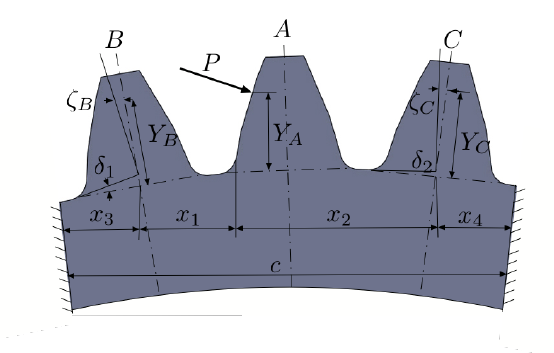
Figure 6. Sketch of Attia’s model as defined in